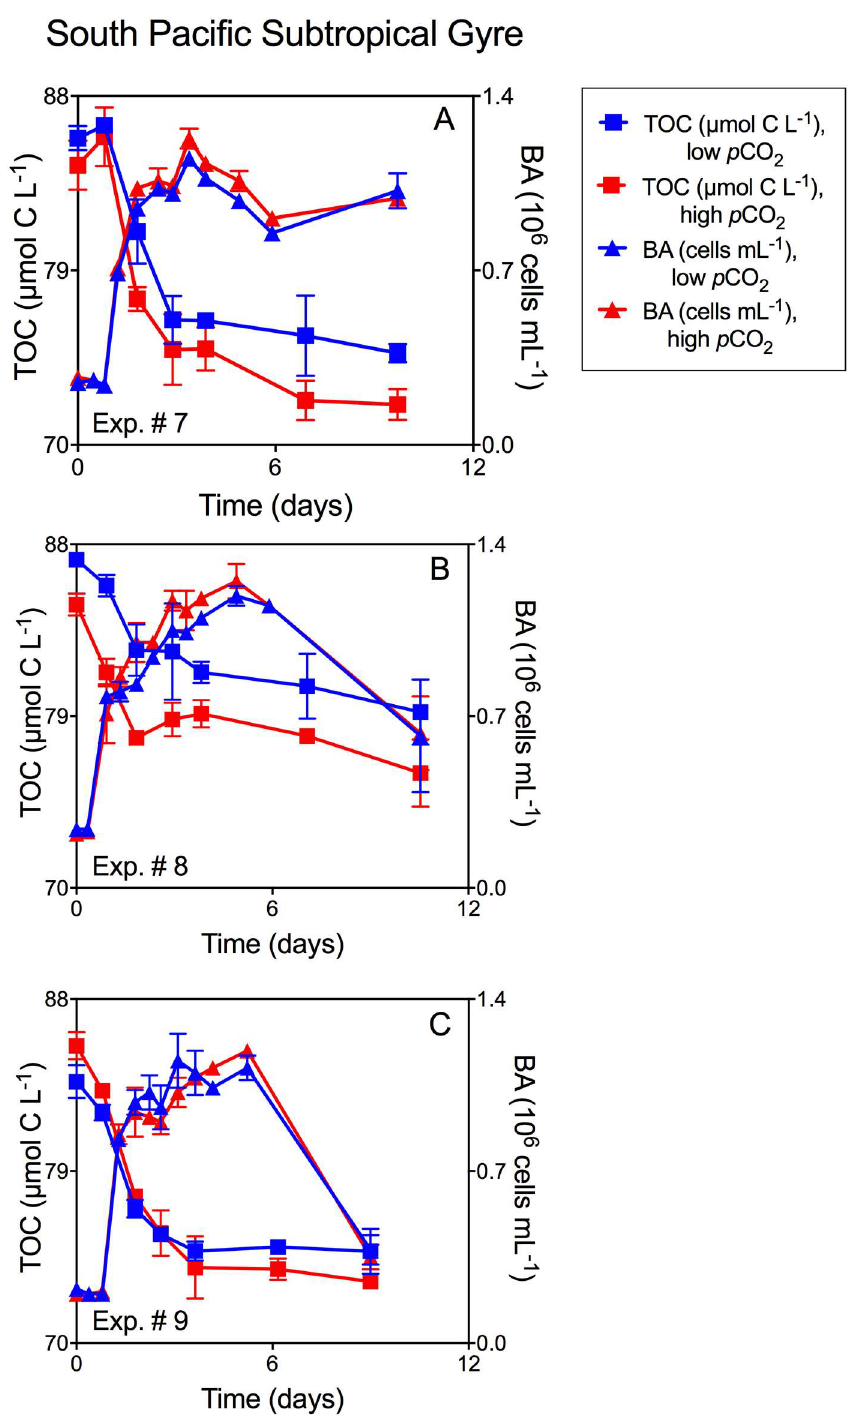
Fig 3. Mean TOC concentration and mean bacterioplankton abundance for phytoplankton-DOC South Pacific Subtropical Gyre experiments. Mean TOC concentration ( ± SD) and mean bacterial abundance (BA; ± SD) averagedacross duplicateincubationsthrough time and as a function of p CO 2 for natural bacterioplankton assemblages in the South Pacific SubtropicalGyre experiments incubatedwith E . huxleyi - derived DOC: A: Exp. #7B; B: Exp. #8B; C: Exp. #9B. The same experimental designwas used for these experiments (note that only the amendedtreatments are shown). Red denoteselevated p CO 2, whileblue denoteslow (250 ppm) p CO 2 . Squares represent TOC ( μ mol C L -1 ) whiletrianglesdenoteBA (10 6 cells mL -1 ) over the course of the incubation.